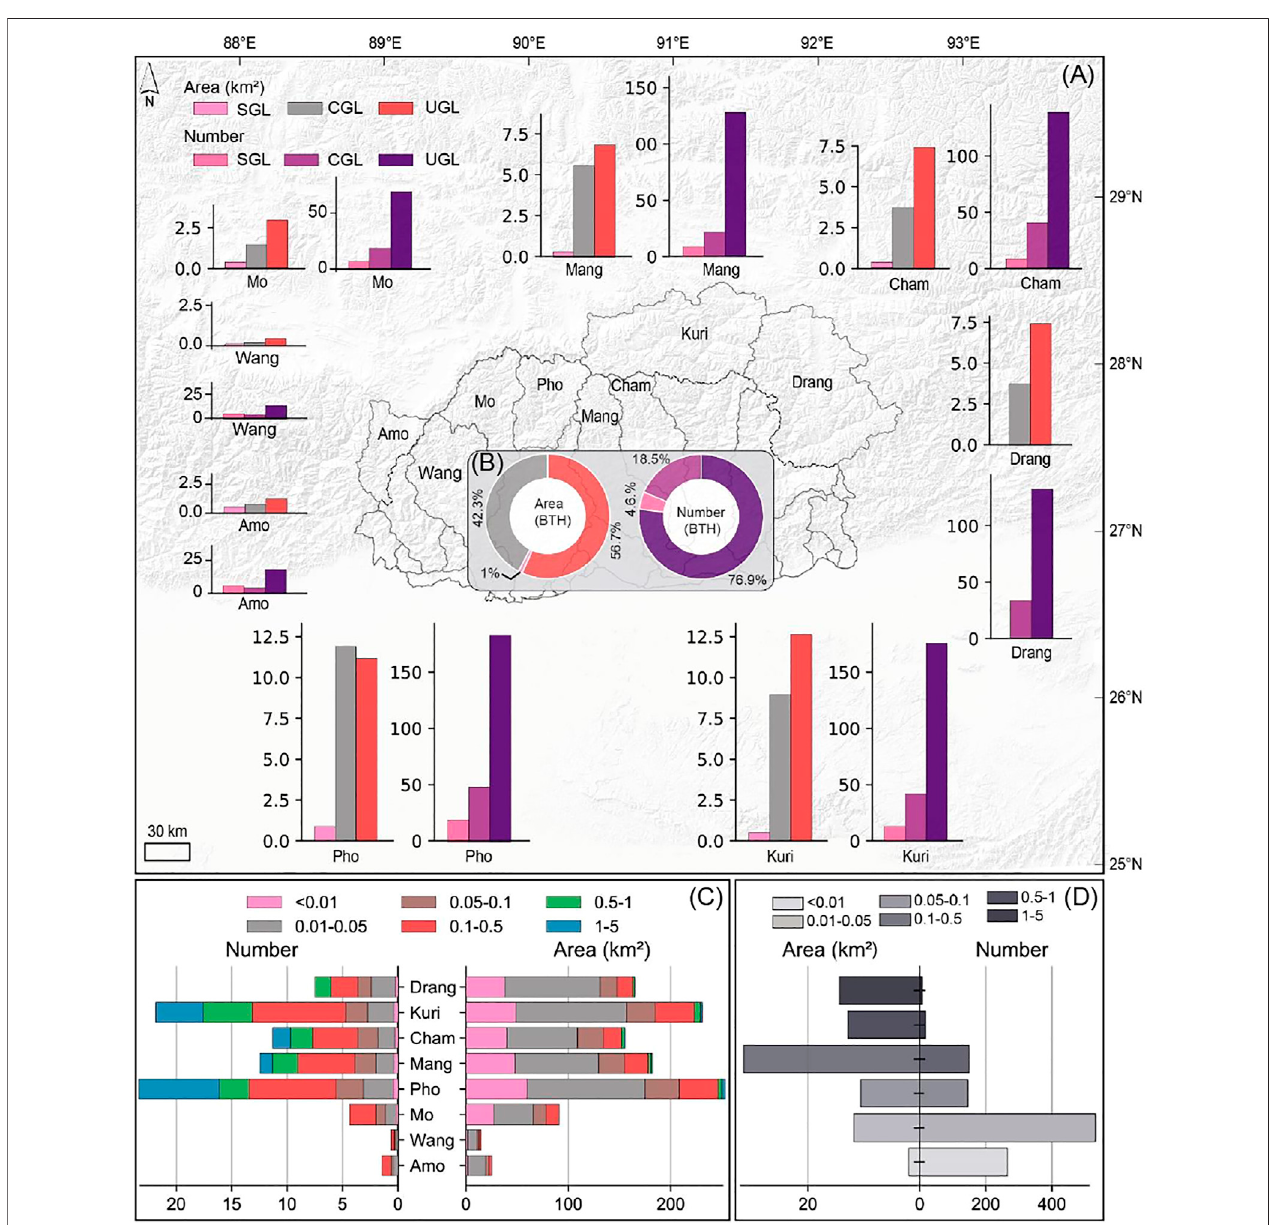
FIGURE 4 | Distribution of different types of glacial lakes: supraglacial (SGL), glacier-connected (CGL), and glacier-unconnected lakes (UGL) across the eight basins (A) andintheentireBTH (B) .Thehorizontalbarsrepresenttheproportionalareaandthenumberofglaciallakesofdifferentsizecategoriesacrosstheeightbasins (C) and the entire (BTH) (D)